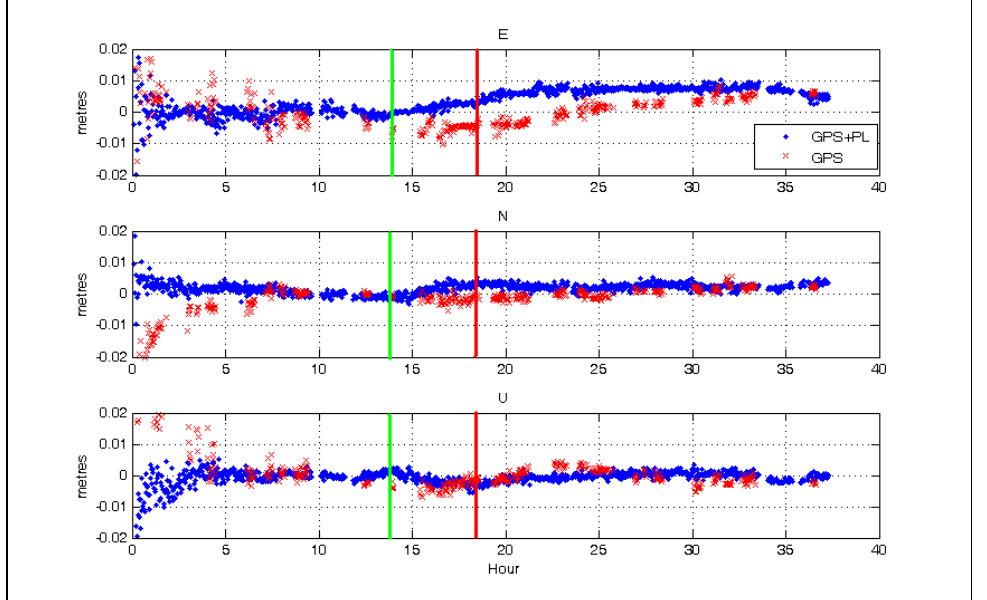
Figure 4. Detected Displacements with and without PL